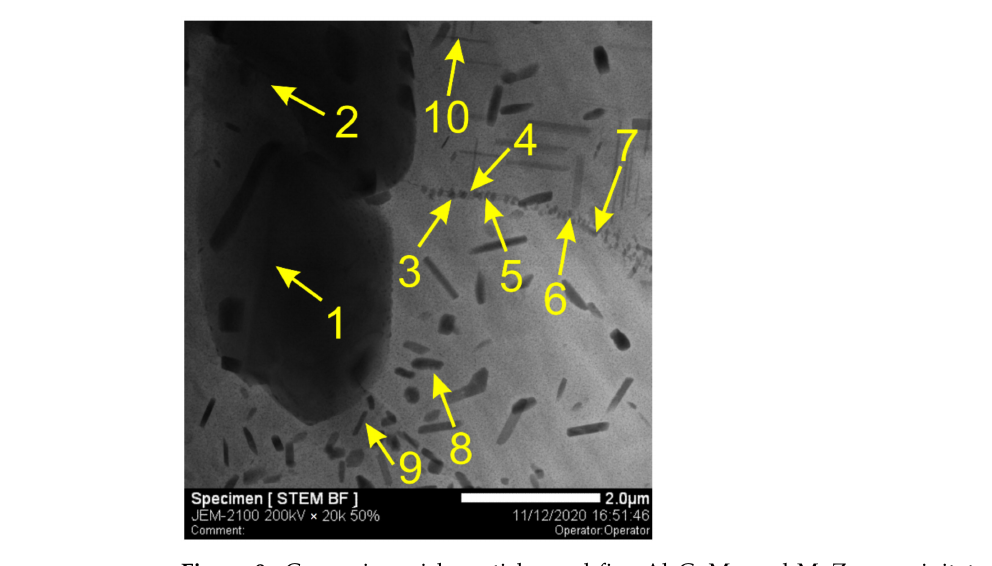
Figure 9. Coarse iron-rich particles and fine Al 2 CuMg and MgZn 2 precipitates in the AA4047/ AA7075 transition zone. Table 4. EDS of particles in Figure 9.